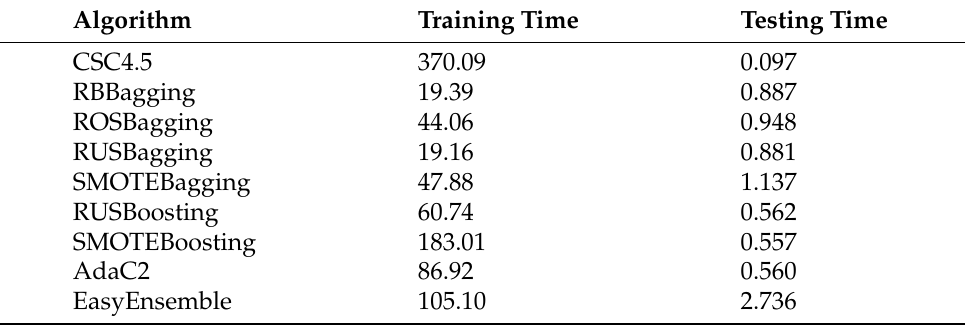
Figure 5. Time required by each classifier in the training and testing stage. Table 2. Average training and testing time required for each algorithm measured in